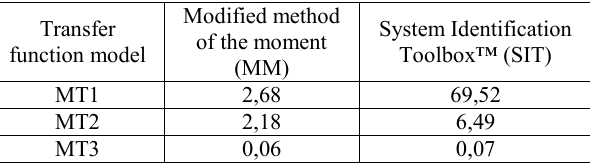
Table 1. Error  calculated from the equation